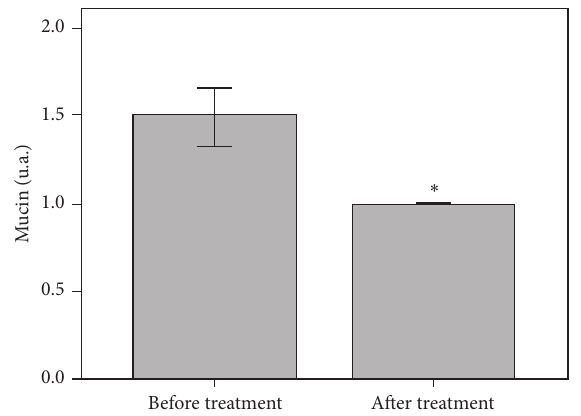
Figure 7: Semiquantitative analysis of mucins showed a 50.0% decrease after treatment compared to baseline ( ∗ 𝑝 ≤ 0.01